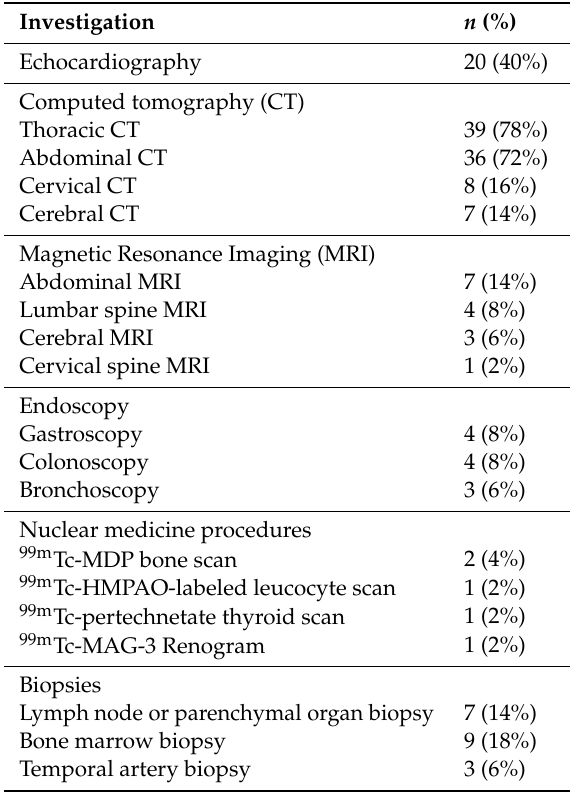
Table 2. Advanced investigations performed prior to PET / CT scan.